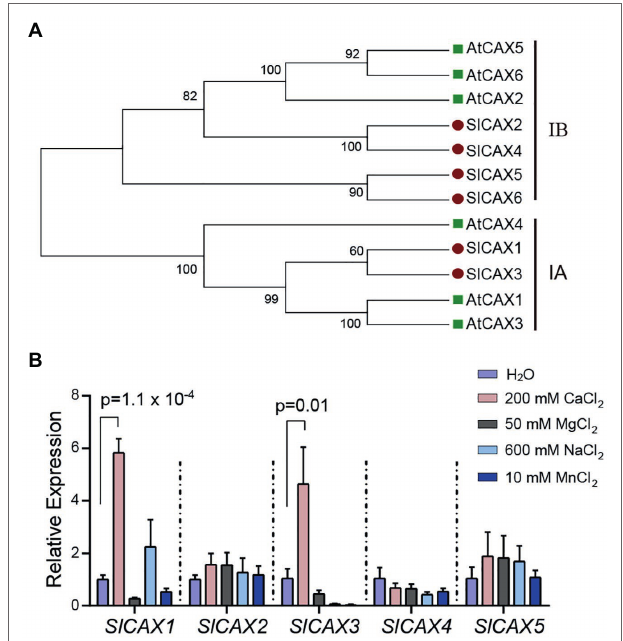
FIGURE 1 | Phylogenetic and expression analysis of SlCAXs . (A) Neighbour- joining tree constructed with MEGA X software (Kumar et al., 2018). The percentages of supported bootstrap scores with 1,000 iterates are shown at the branch nodes. (B) Relative expression of the SlCAX family under different cation treatment conditions. The 14-day-old tomato seedlings were treated with different ion solutions for 16 h. Whole seedlings were collected for qPCR, and the expression of SlCAX genes was determined. The gene expression level under the H 2 O treatment was set as 1, and the data indicate the mean value ± SE from three biological replicates. Student’s t -test was used to analyse the